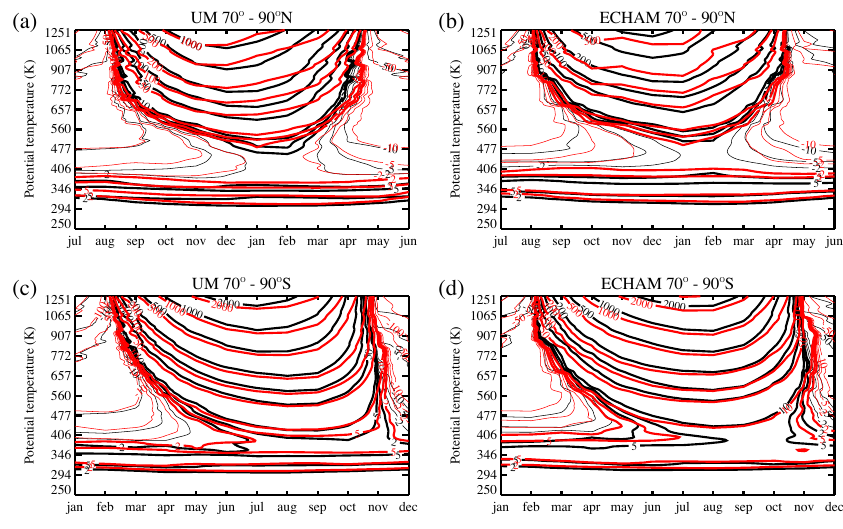
Fig. 1. Monthly climatological polarcap PV anomaly (area-weighted average between 70 ◦ and 90 ◦ , in PVU, 1 PVU = 10 − 6 Km 2 kg − 1 s − 1 ) for the control run (black) and the doubled CO 2 run (red), for (a) the NH UM model, (b) the NH ECHAM model, (c) minus the SH UM model and (d) minus the SH ECHAM model, as a function of time (months) and potential temperature (K). Contours at ± 2, 5, 10, 50, 100, 200, 500, 1000, 2000, 3000 PVU, positive values represented by thick lines and negative values represented by thin lines. Note that for both hemispheres the horizontal axis starts in summer.